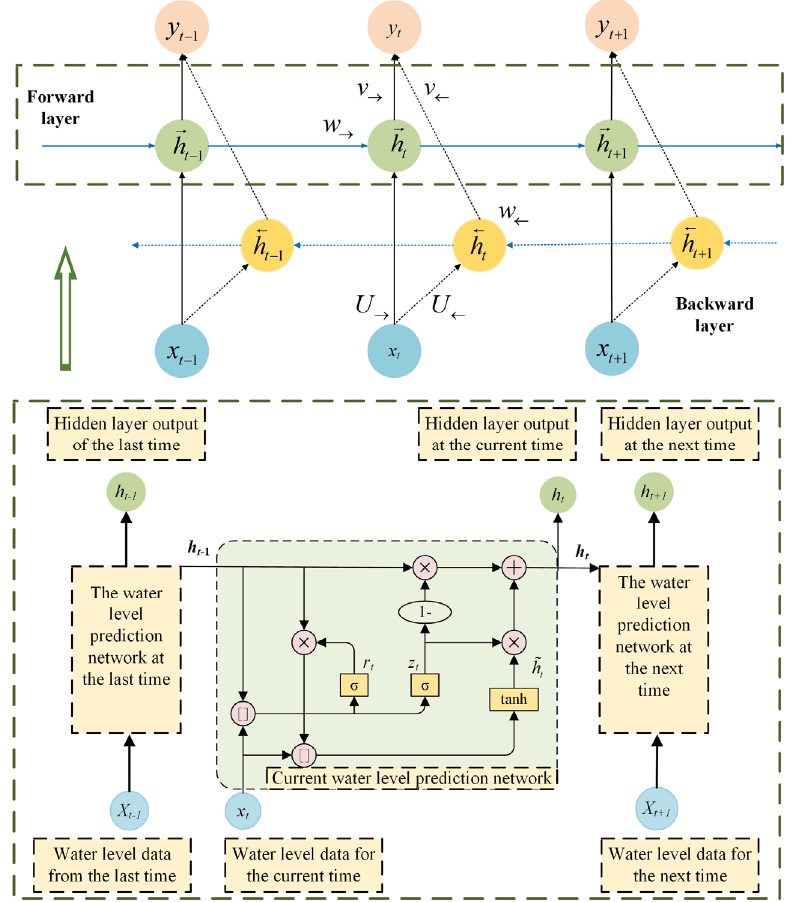
Figure 5. Bidirectional gate recurrent unit.